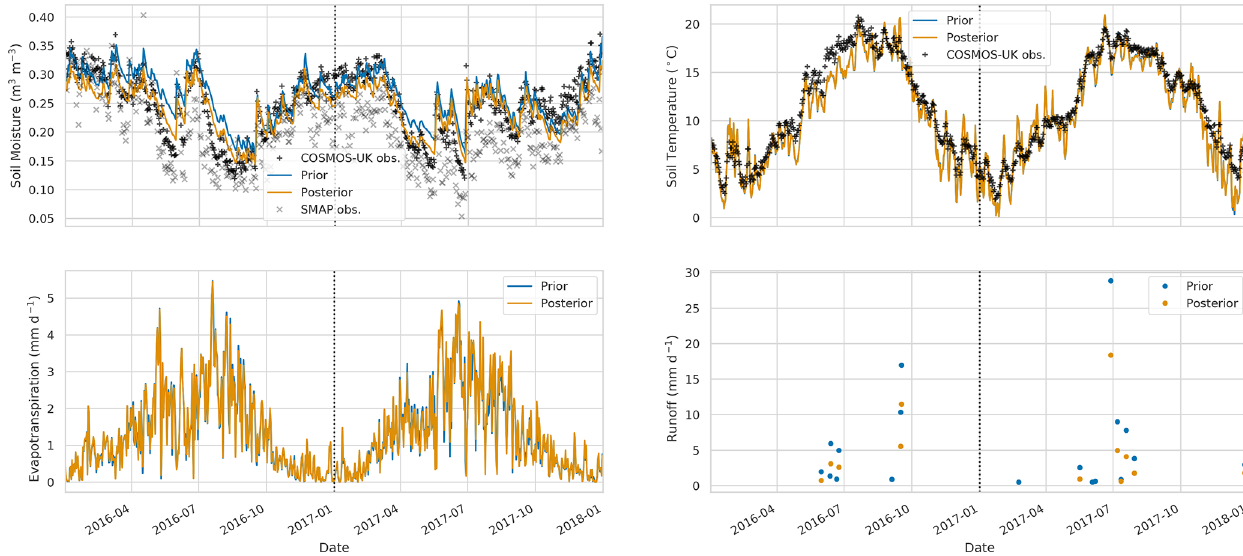
Figure 12. Time series of water budget variables and soil temperature at Morley COSMOS site. Black plus signs: COSMOS-UK observations, grey crosses: SMAP observations for closest 9km pixel, blue line: prior JULES estimate for closest 1km grid cell, orange line: posterior JULES estimate for closest 1km grid